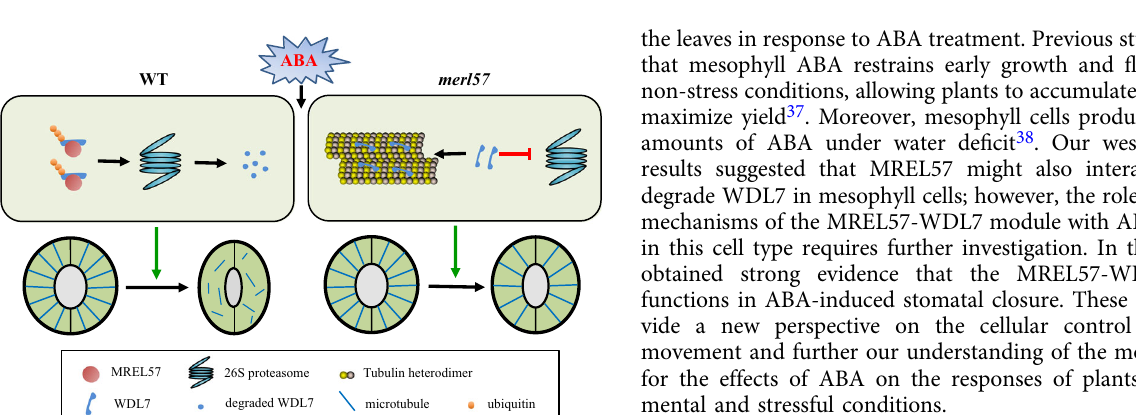
Fig. 7 Degradation of WDL7 is required for MREL57-mediated stomatal closure in response to ABA. a Detached rosette leaves of seedlings from YFP- tubulin , WDL7-GFP , and WDL7-GFP / mrel57-1 were incubated in opening buffer for 2 h and then treated with 10 μ M ABA plus 20 μ M Taxol for 40 min. Confocal images of the guard cells and pavement cells were taken. Scale bar = 10 μ m. b The graphs show the relative fl uorescence in a . Data represent mean ± standard deviation (SD) values from three independent experiments with a minimum of 15 cells each. Different letters represent signi fi cant differences at p < 0.01 (one-way ANOVA). c Degradation of WDL7 was clearly decreased in mrel57-1 mutant in a cell-free degradation assay. Puri fi ed MBP- WDL7-FLAG was incubated with equal amounts of total proteins from 10-day-old WT and mrel57-1 seedlings. MBP-WDL7-FLAG was detected with anti- FLAG antibody. Actin was used as a control. d Quantitative analysis of protein levels in c . The WDL7 protein level at 0 h was set to 1 as a reference for calculating the relative protein levels at the various time points. Data represent the mean ± SD for three independent experiments. Two-tailed Student ’ s t test, * p < 0.05. e Ten-day-old WDL7-GFP and WDL7-GFP/mrel57-1 transgenic seedlings were treated with 100 μ M CHX, 100 μ M CHX plus ABA, or 100 μ M CHX plus ABA and MG132 for the indicated times and then total protein was extracted from the leaves. WDL7-GFP was detected with an